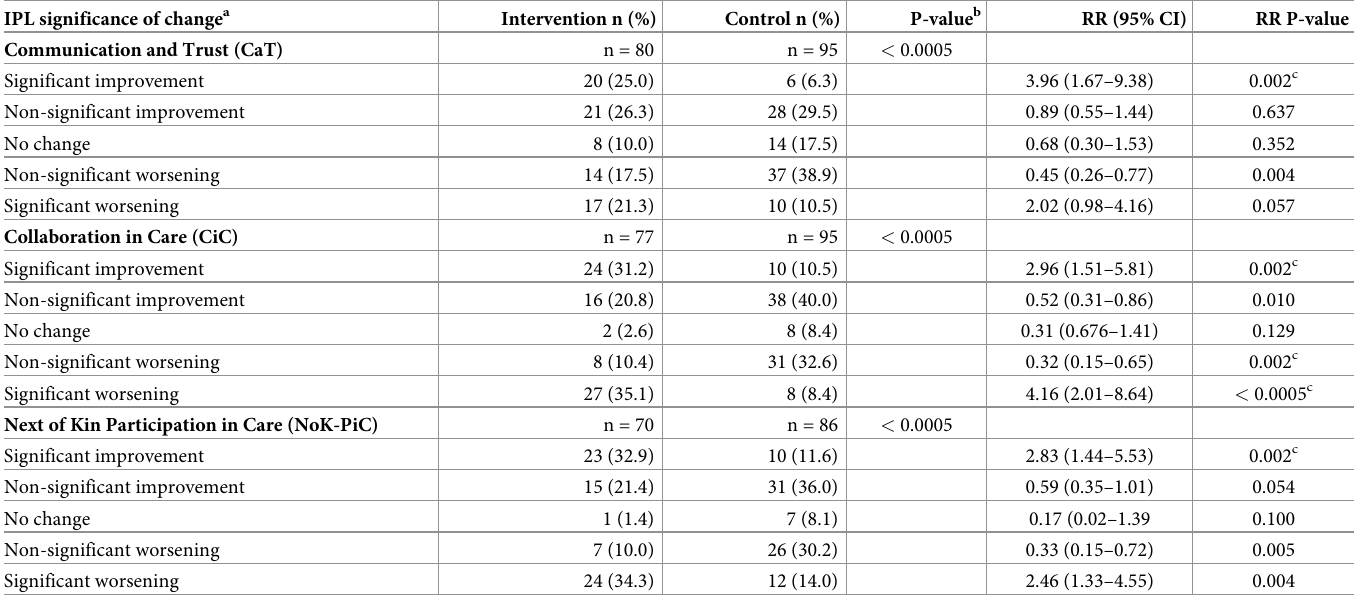
Table 3. Comparisons of individual person-level (IPL) change in Communication and Trust, Collaboration in Care subscale scores, and Next of Kin Participation in Care (NoK-PiC) scores between the intervention group and the control